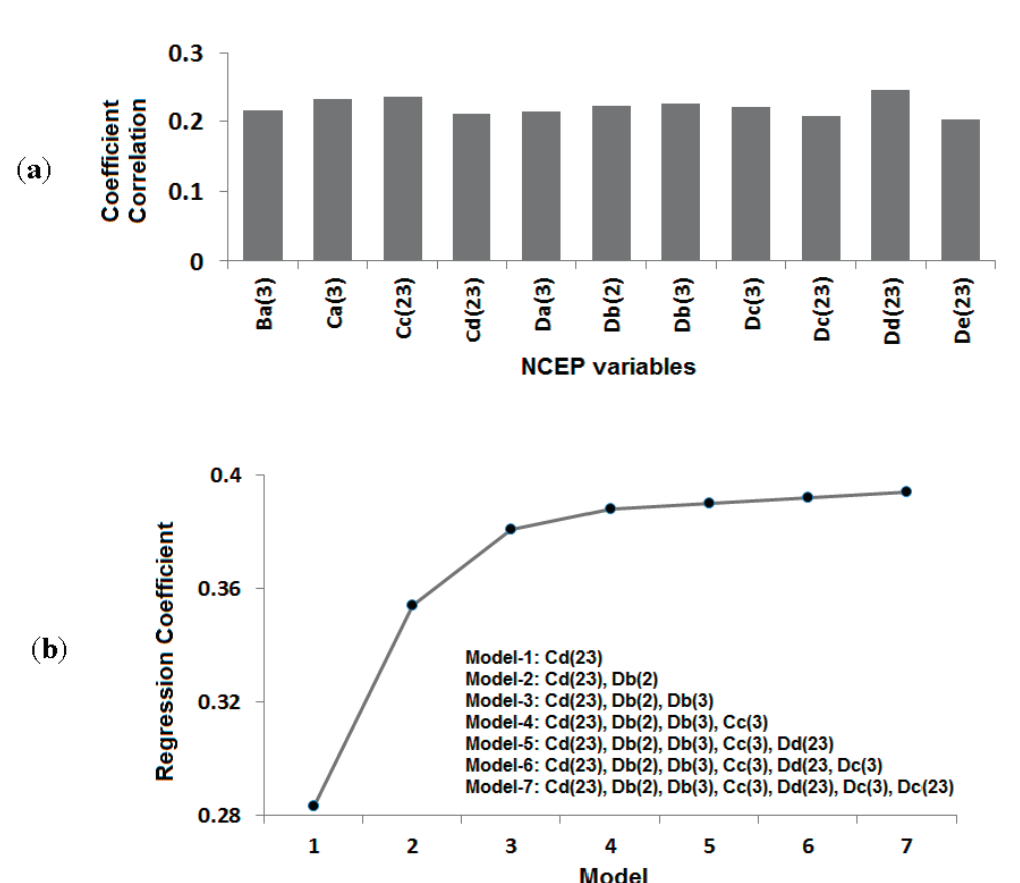
Figure 3. ( a ) The NCEP variables from different grid points with good correlation with heavy rainfall events during the NE monsoon; ( b ) the plot of regression coefficients between different subsets of NCEP variables and heavy rainfall events at Dungun